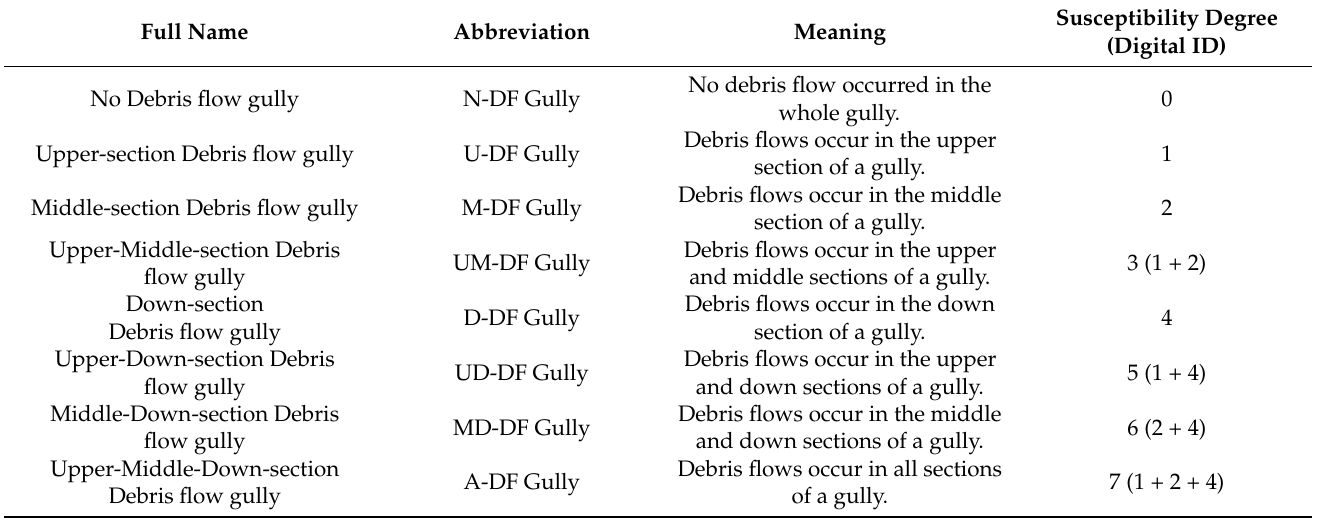
Table 2. Classifications of debris flow gullies and definition of SDs.